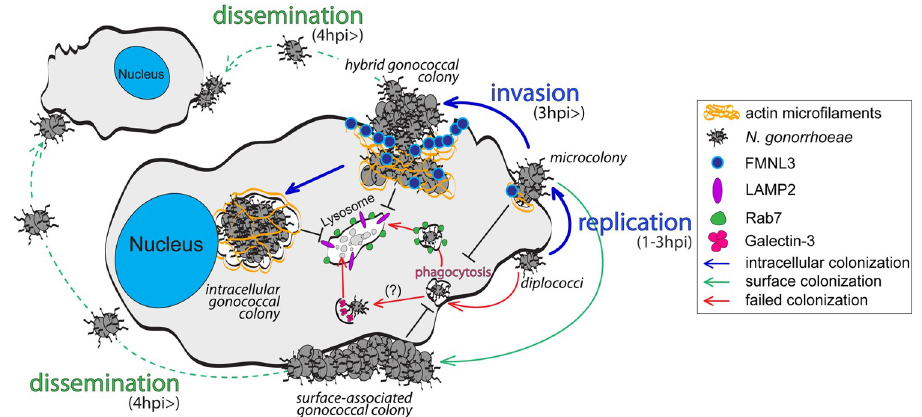
Fig 10. Model of macrophage colonization and invasion by gonococcal colonies. The diagram illustrates the proposed model of the three distinct stages of colonization of MFs by N.g and identifies several regulatory factors involved in the process (see “Discussion” for